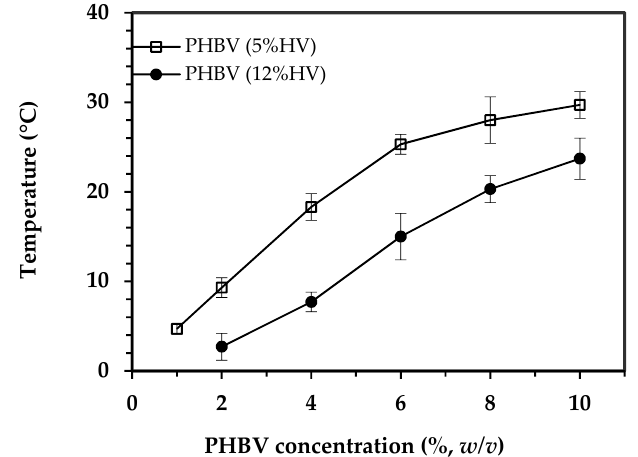
Figure 2. Cloud point curves at relatively low concentrations of PHBV(5%HV)-dioxane and PHBV(12%HV)-dioxane solutions.